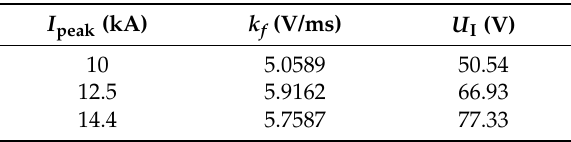
Table 2. k f and U I calculated by